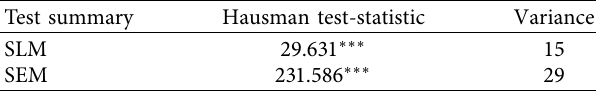
Table 6: Hausman test results.